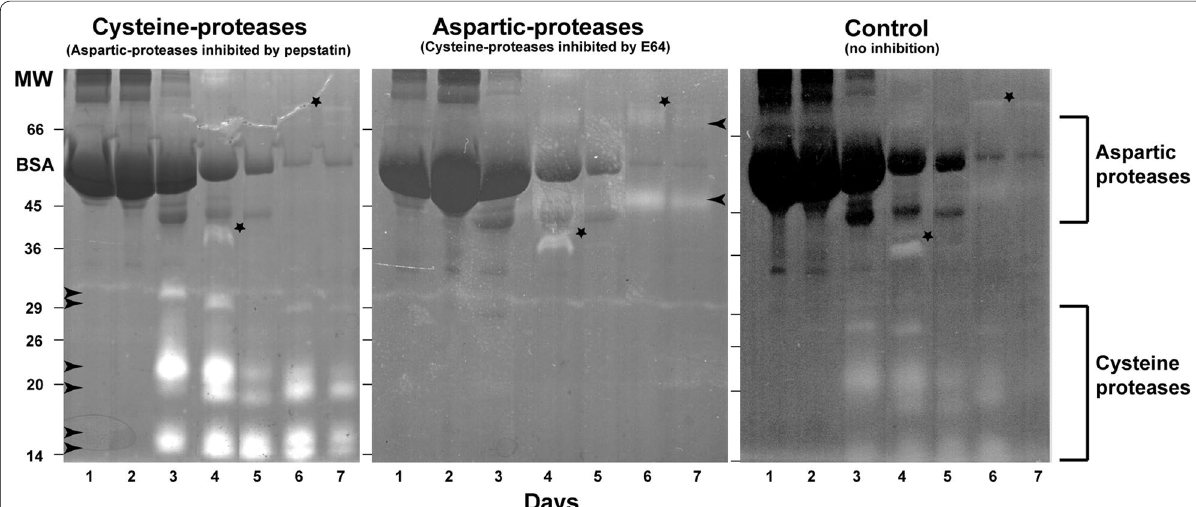
Fig. 3 Zymogram gels of Venus flytrap eluates. The lighter stained gel bands mark sites of different proteases separated by electrophoresis. The distinction between cysteine and aspartic proteases is based on inclusion of two protease inhibitors, pepstatin and E64 in the gels. The control gel contained no inhibitors. The arrowheads mark the positions of reproducibly identified proteases. The starred bands are of unknown origin. Note the size differences of the cysteine and aspartic